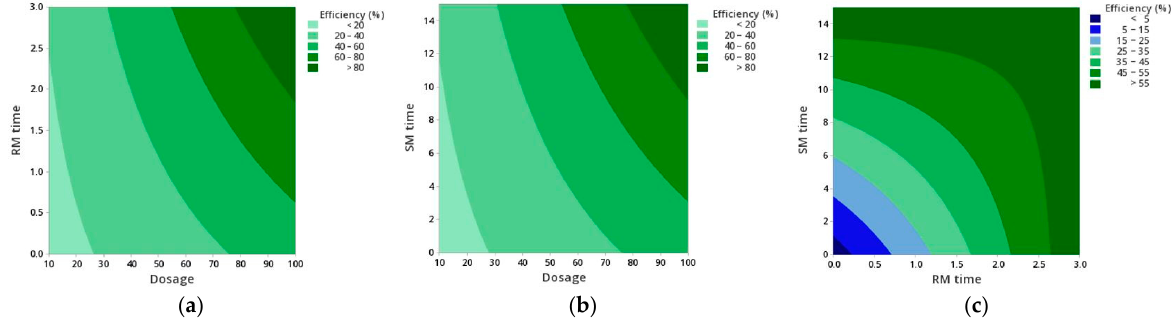
Figure 2. Contour diagrams of C. vulgaris harvesting efficiency as a function of the statistically significant factors: ( a ) Dosage vs. RM time; ( b ) Dosage vs. SM time; ( c ) RM time vs. SM time.